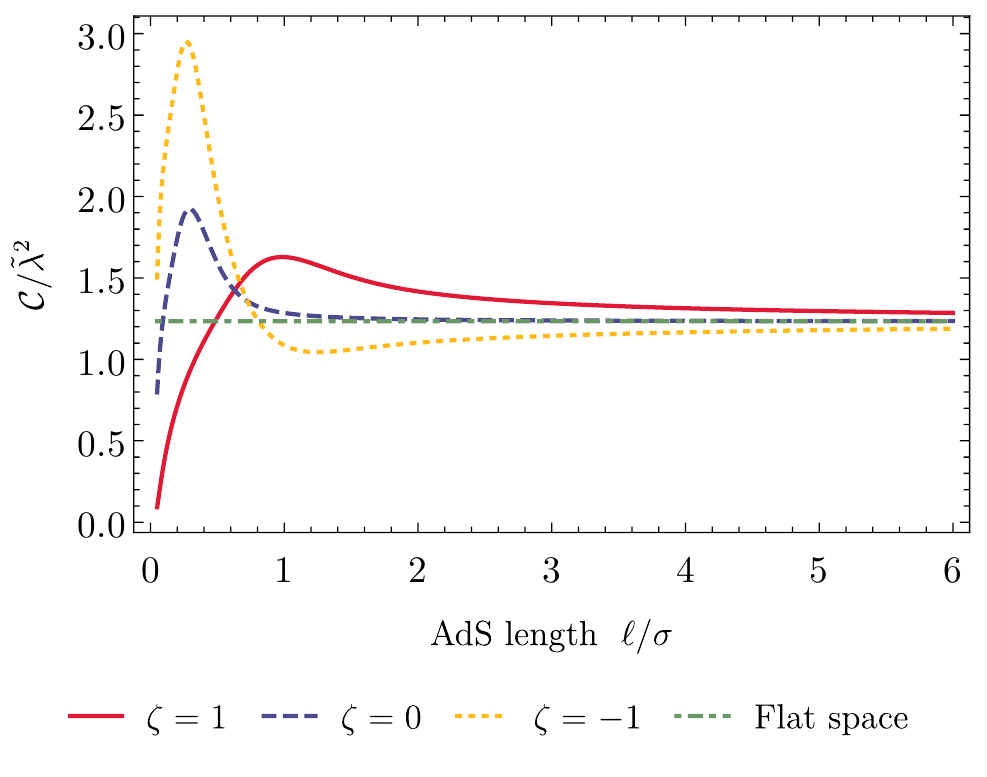
Figure 4 . The concurrence C = ~ (cid:21) 2 associated with the state (cid:26) AB describing two static detectors is plotted as a function of the AdS length ‘=(cid:27) for all boundary conditions (cid:16) = f 1 ; 0 ; (cid:0) 1 g . The proper separation of the detectors is d ( R A ; R B ) =(cid:27) = 1 = 10, their energy gap is (cid:10) (cid:27) = 1 = 100, and detector A is located at the